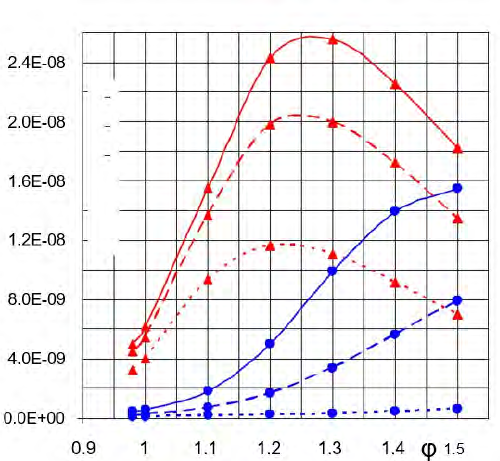
Figure 11. S max (æ), S exhaust (—) vsequivalence ratio with different diesel content in the fuel (: D25, –: D20, ··· :